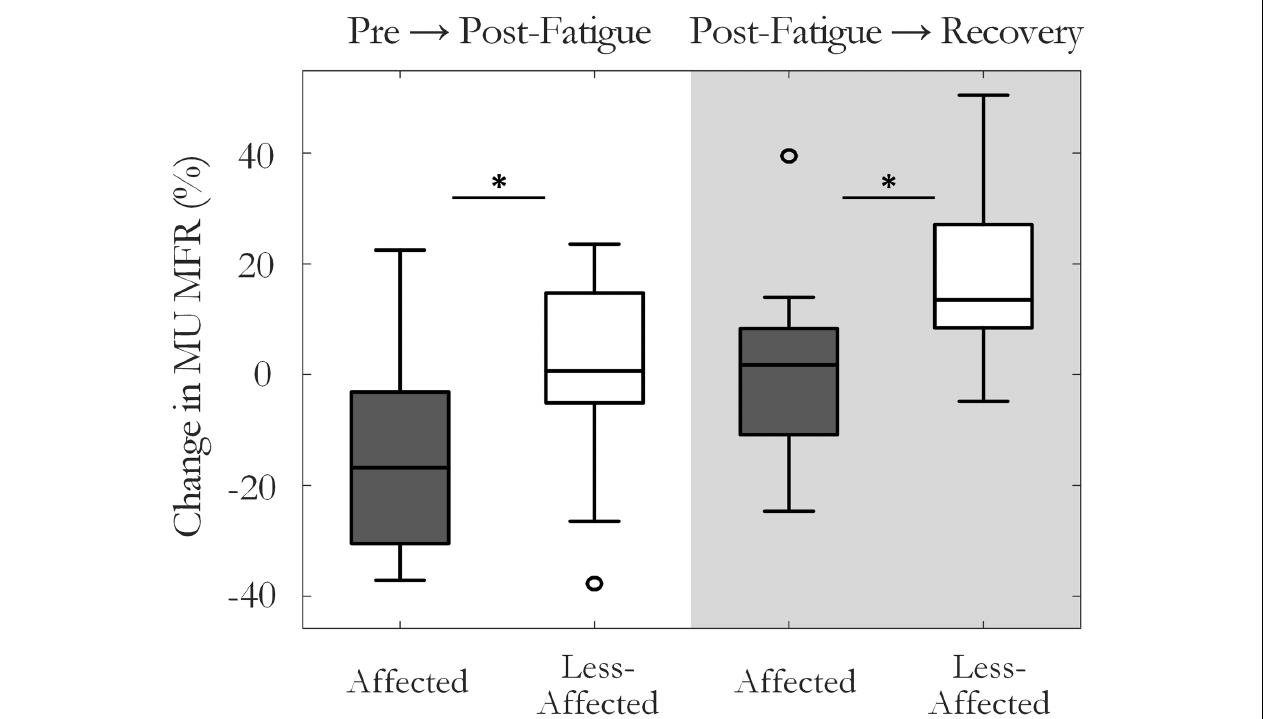
FIGURE 4 | Median and interquartile range of the percentage change in MU firing rate on the affected and less-affected sides, comparing MUs detected pre-fatigue and post-fatigue, and pre-fatigue with MUs detected after the recovery period ( ∗ p < 0.05).